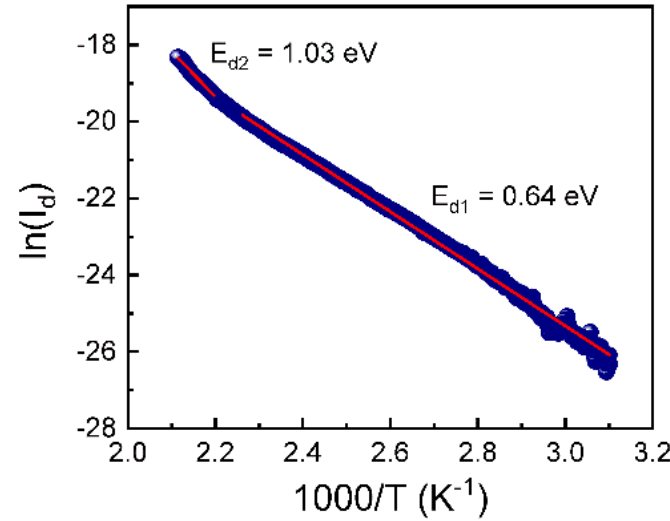
Figure 6. Arrhenius plot of dark current .